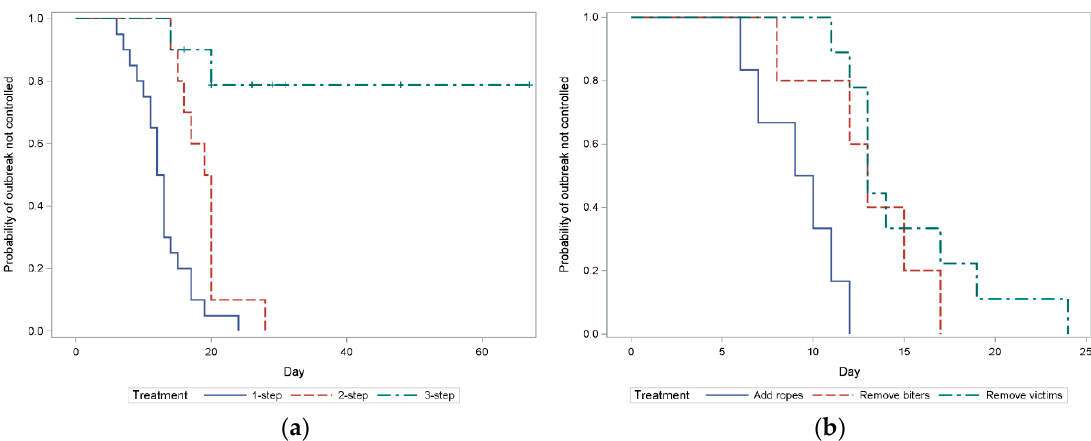
Figure 3. Kaplan–Meier survival plots for the probability (y-axis) of a tail biting outbreak continuing, where higher survival probability represented a higher chance that the tail biting outbreak was continuing and not controlled. ( a ) Number of interventions used, blue solid line: outbreaks with one intervention used, red dashed line: two interventions, and green dashed-dotted line: three interventions. ( b ) The outbreaks that were successfully controlled with one intervention: blue solid line: adding ropes, red dashed line: removing biters, green dashed-dotted line: removing victims.